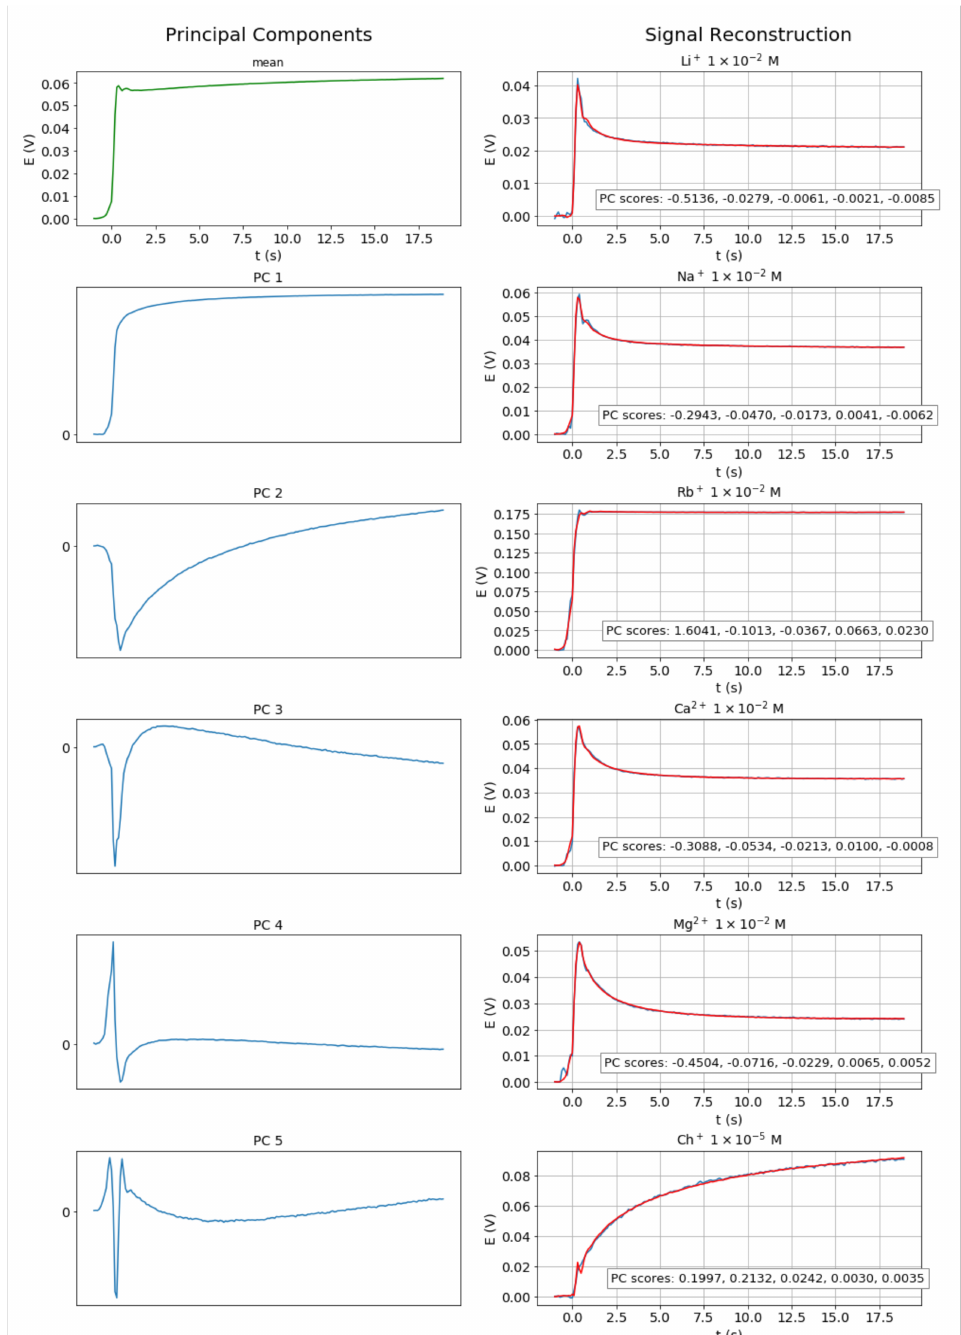
Figure 3. Principal components of the pool of signals ( left ) and reconstructed (red) over experimental (blue) signals ( right